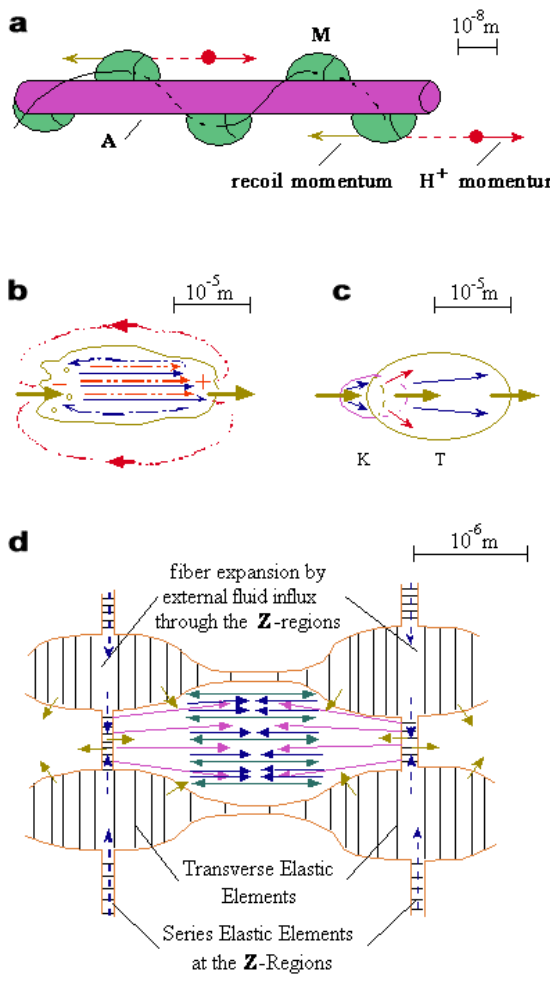
Figure 2. Ballistic protons and water solitons in